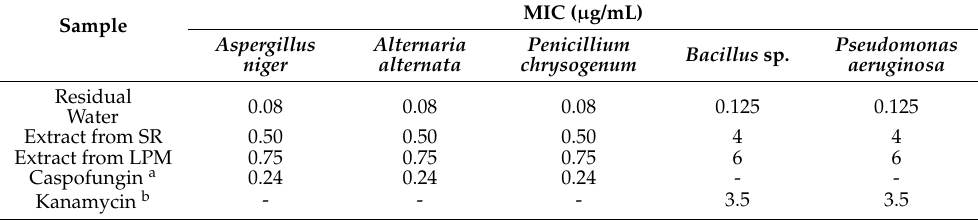
Table 6. The antimicrobial activity of residual water and ethanolic extracts from lavender plants. MIC ( µ g/mL) Sample Aspergillus Alternaria Penicillium niger alternata chrysogenum Bacillus